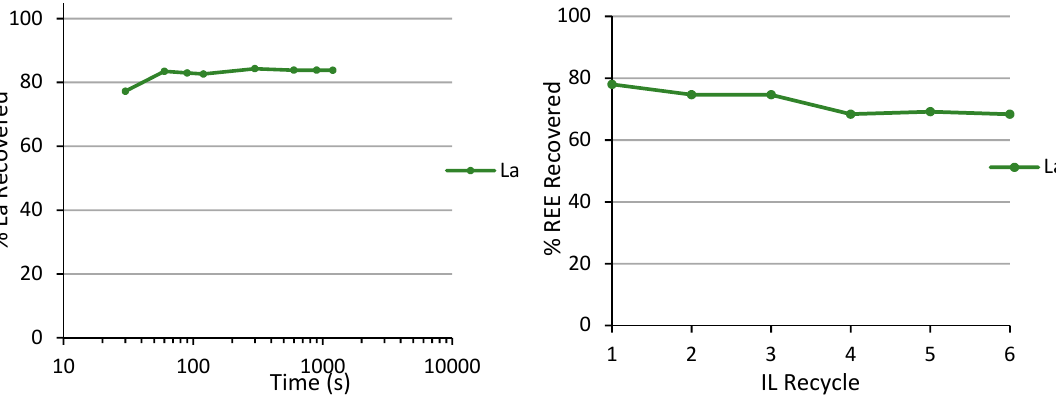
Figure 3. ( Left ): The recovery of La (0.01 M) in NaNO 3 (7 M) using IL (0.1 M) with varying time (seconds). ( Right ): The recycling of IL (0.1 M) to load La (0.01 M) from aqueous NaNO 3 (7 M) following multiple load/strip cycles. Water was used to strip La (100%). Interpolation used to aid the eye only.